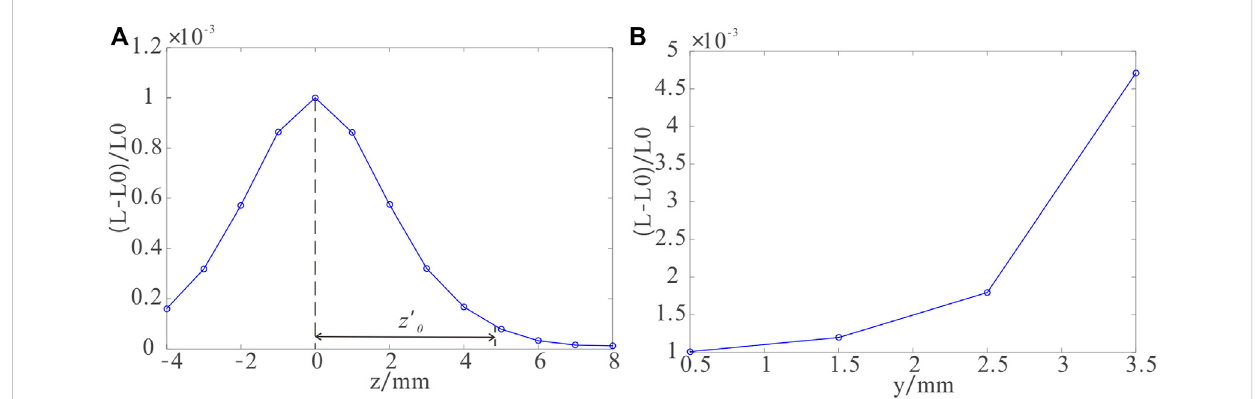
FIGURE 4 (A) Change in coil inductance when a particle moves along the central axis of the coil and (B) change in coil inductance when a particle moves radially toward the coil.